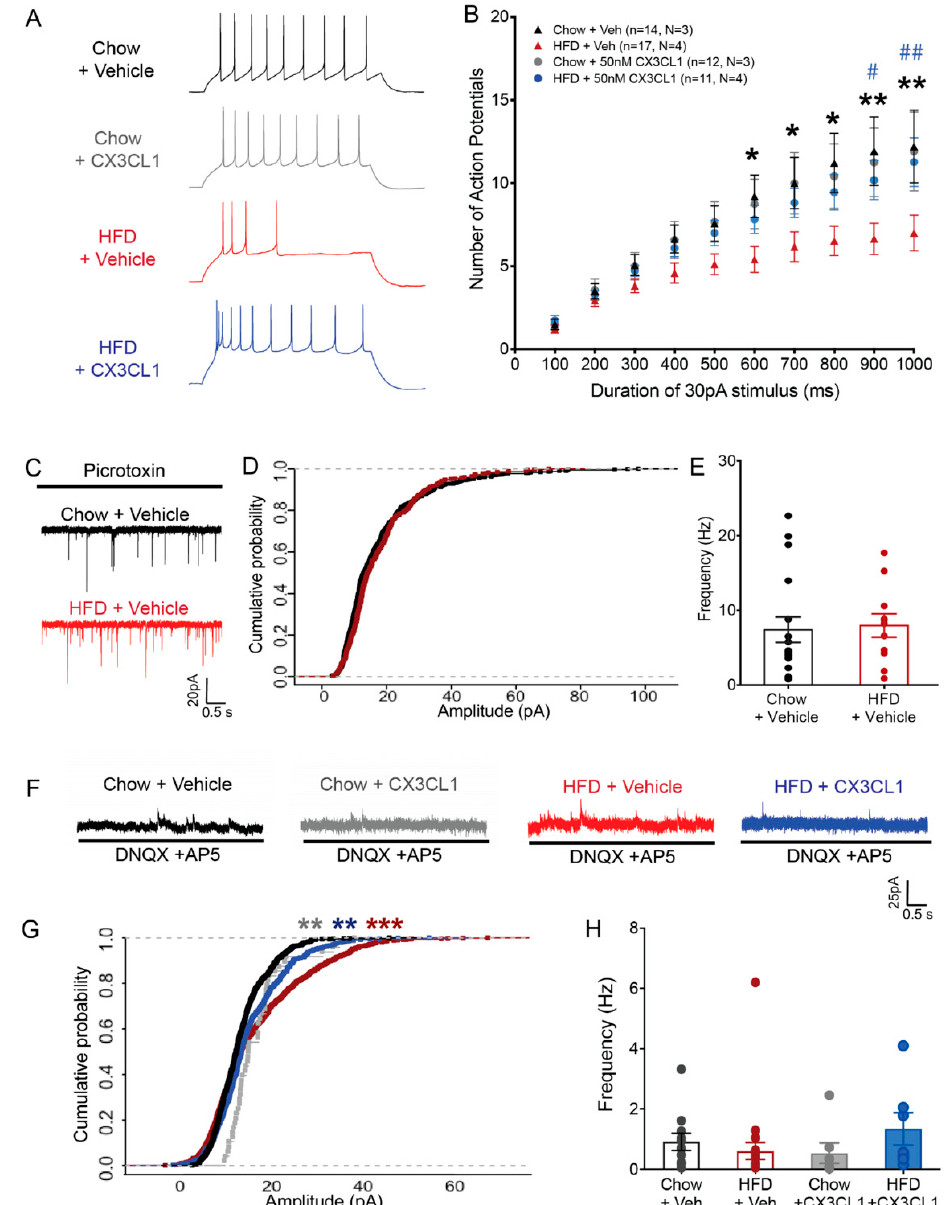
Figure 3. CX3CL1 restores intrinsic excitability of POMC neurons in DIO mice. ( A ) Representative traces of POMC neurons after stimulation by 1000 ms 30 pA current step (top: stimulus step; bottom: responses: black: Chow + Veh, gray: Chow + CX3CL1, red: HFD + Veh, blue: HFD + CX3CL1). ( B ) Population data of evoked responses of POMC neurons to variable duration of stimulus after vehi-